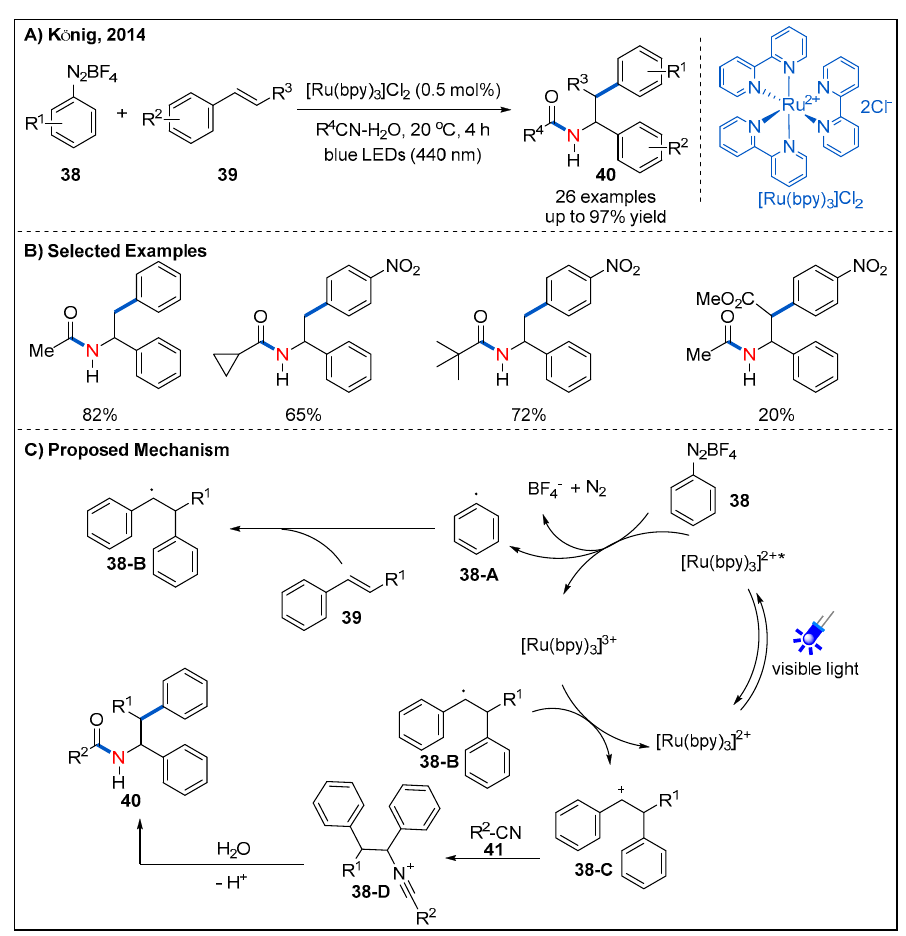
Figure 15. Photoredox-catalyzed Meerwein addition and Ritter-type amination reaction. In 2017, Chen, Liu, and co-workers developed a photoredox catalyzed strategy for C(sp 3 )–H amidation of tertiary and benzylic C-H bonds of 42 or 43 (Figure 16) [46]. The best conditions involve using [Ru(bpy) 3 ]Cl 2 as a photoredox catalyst in the presence of hydroxyl perfluorobenziodoxole (PFBI-OH) 46 or hydroxyl benziodoxole (BI-OH) as an external oxidant. The major advantage of this catalytic system is the excellent regioselectivity of HAT process. As described in Figure 16C, the mechanism of this tertiary C–H amidation begins with a SET from the photoexcited [Ru(bpy) 3 ] 2+ * to PFBl–OH, generating an oxygen radical 46-A . This radical species abstracts a hydrogen atom from alkane, generating a tertiary carbon radical 42-A . Tertiary carbon radical can then be oxidized by [Ru(bpy) 3 ] 3+ , forming tertiary carbocation intermediate 42-B and regenerating the photocatalyst. Finally, trapping of tertiary carbocation 42-B by MeCN, followed by hydrolysis to yield the corresponding amide via a Ritter-type reaction mechanism.